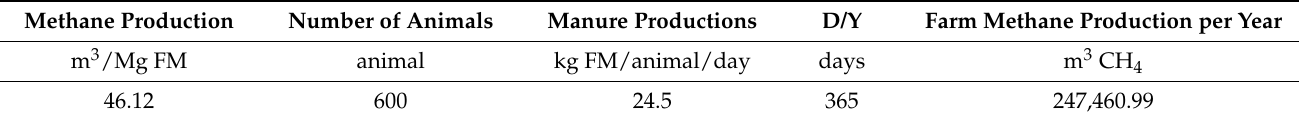
Table 6. Annually produced methane of solid